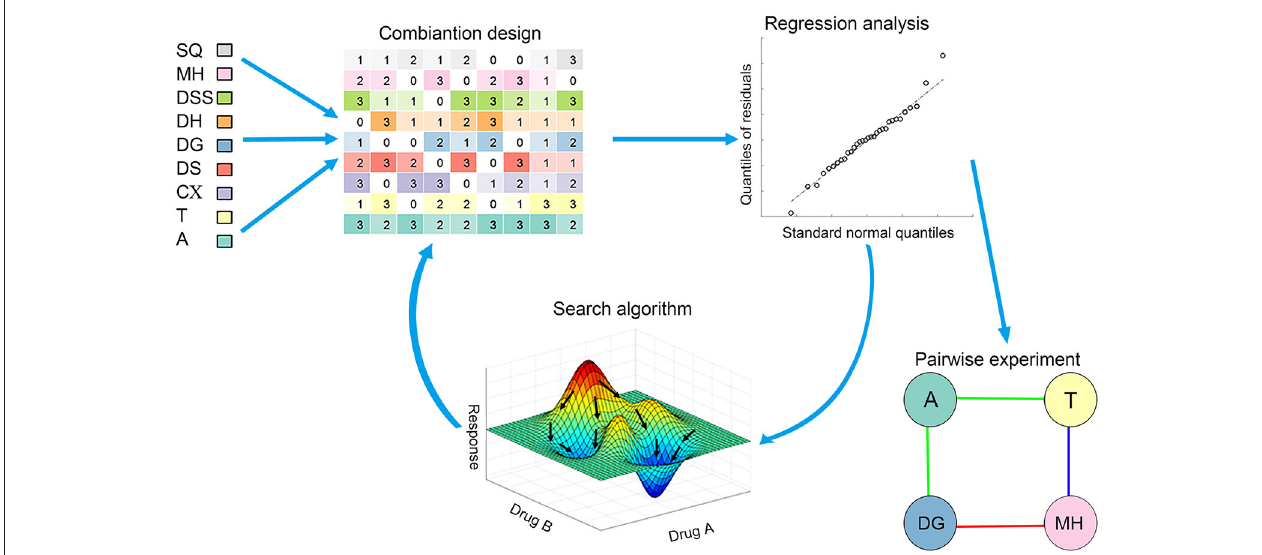
FIGURE 1 | Scheme of the FSC application in this study. The optimization process is based on an iterative cycle, in each generation drug combinations were tested in vitro and analyzed with mathematical models. The feedback search algorithm therefore uses the difference between the results of the tested combinations and the desired optimization goals to predict new combinations to be tested in the next generation. After the optimization process, we conducted a pairwise experiment to confirm conclusion from the FSC optimization